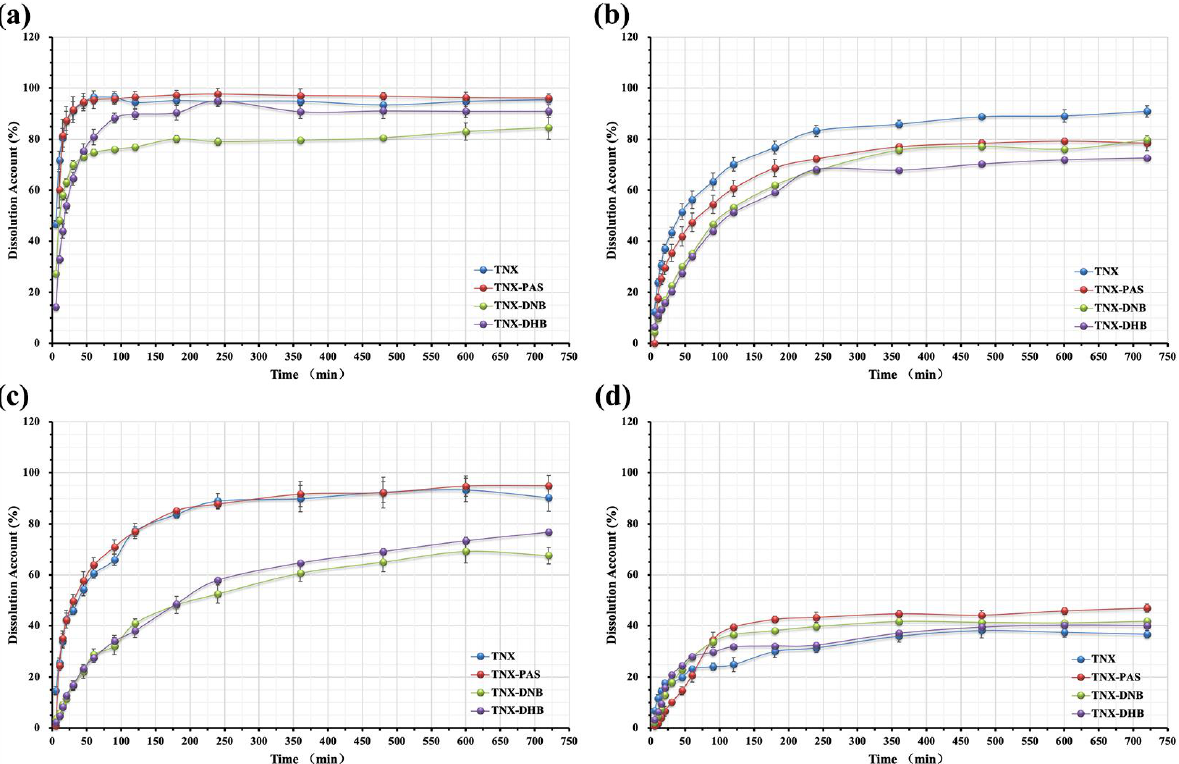
Figure 9. Powder dissolution profiles of the cocrystals and salt of TNX in four solvent systems. ( a ) Hydrochloric buffer (pH 1.2); ( b ) acetate buffer (pH 4.5); ( c ) phosphate buffer (pH 6.8); and ( d ) water (pH 7.0).